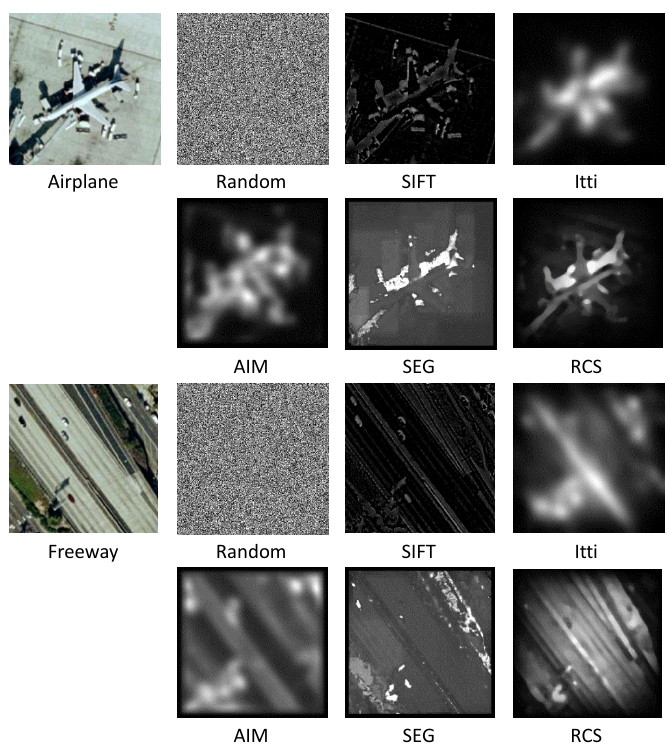
Figure 7. The response maps of different sampling methods on two example images from the UC-Merced dataset. For saliency-based sampling, the saliency maps are linearly normalized to be in the range of [0 , 255] as the response maps. The response map of random sampling is produced from an independent uniform distribution between [0 , 255] . These maps are of the same size as the treated images, and they can be used as masks to guide the sampling procedure: the brighter the region, the more likely it is to be sampled from the